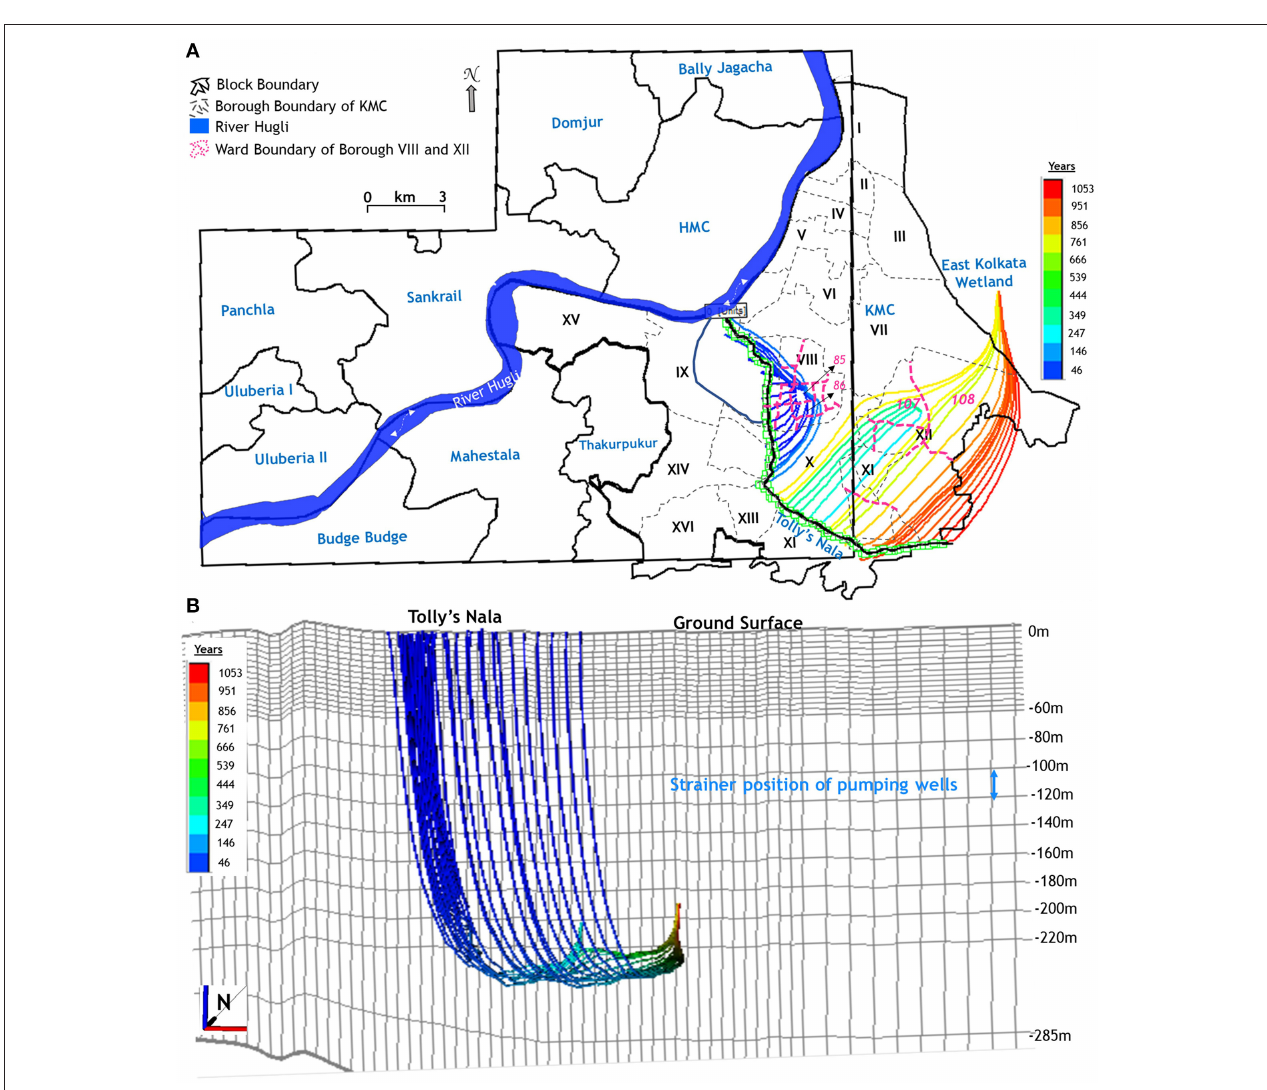
FIGURE 12 | (A) Path lines of forward tracked particle under future development pumping conditions. (B) 3-D view of particle path lines from Tolly’s Nala (recharge area) into the aquifer under future development conditions; vertical exaggeration is 75x.